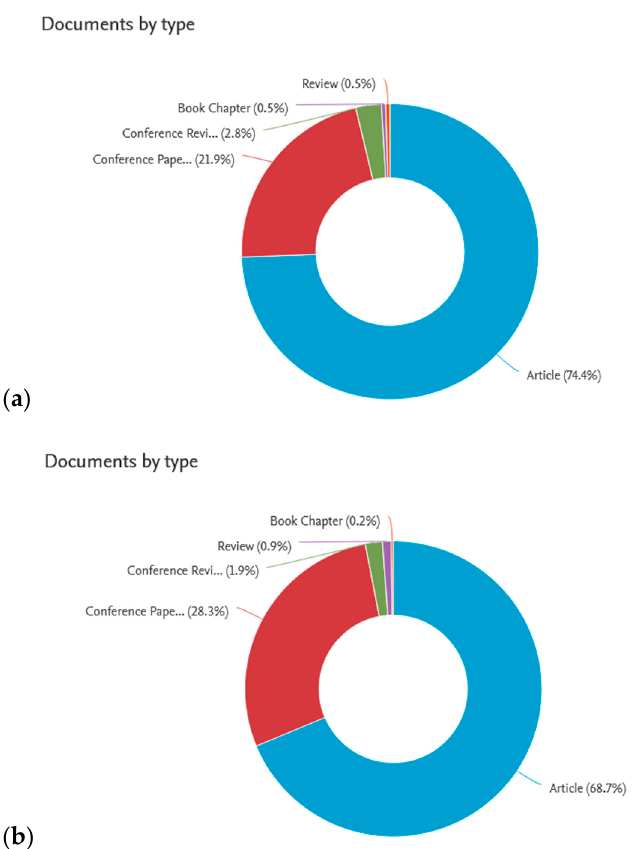
Figure 2. Document type distribution for ( a ) “ Seismic design ” AND “ Steel joints ” OR “ Steel Connec- tions ” OR “ Bolted connections ” OR “ Bolted joints ” and ( b ) “ Earthquake ” AND “ Steel joints ” OR “ Steel Connections” OR “ Bolted connections ” OR “ Bolted joints ”.